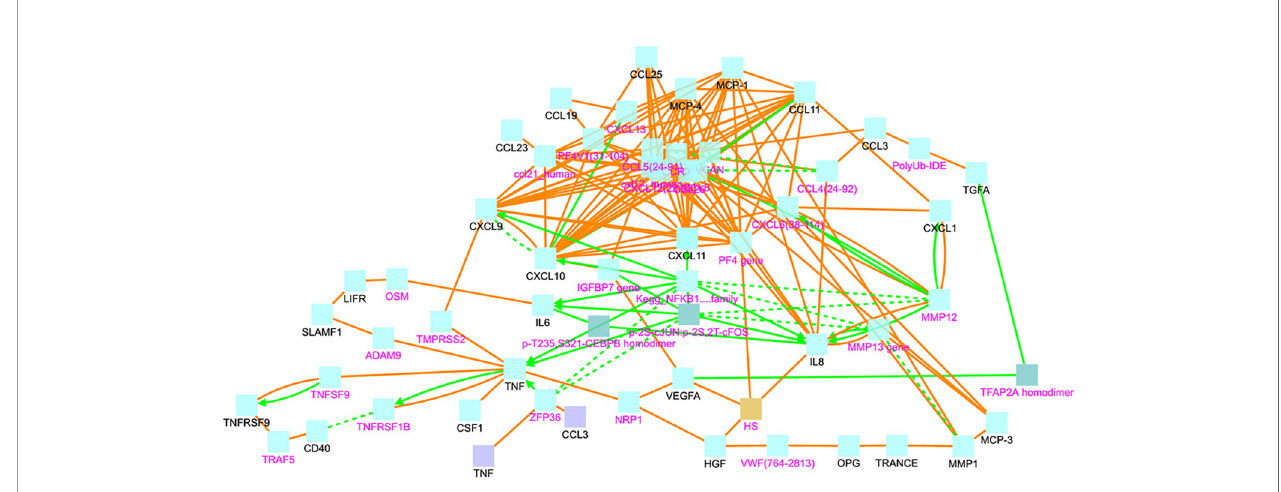
FIGURE 5 | Induced network analysis showing the protein-protein interactions (orange line) and biochemical reactions (green lines) among the differentially expressed proteins (black letters) or mediated by interconnecting nodes (magenta letters). VWF, von Villebrand Factor; HS, heparan